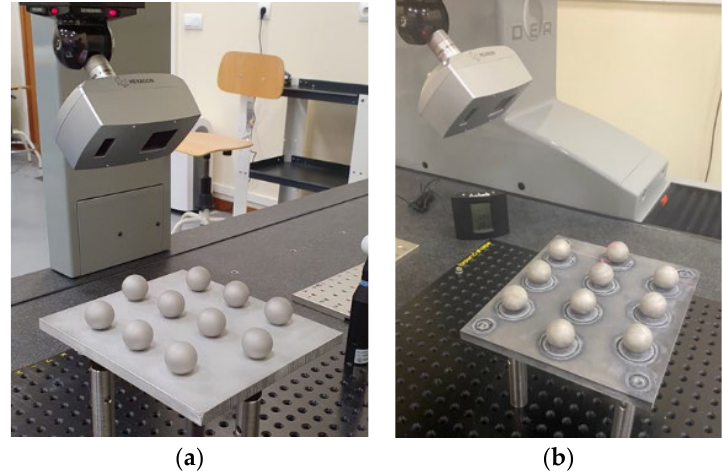
Figure 7. Contact measurements of sets of spheres after each treatment. ( a ) After sandblasting ( b ) After chemical etching.